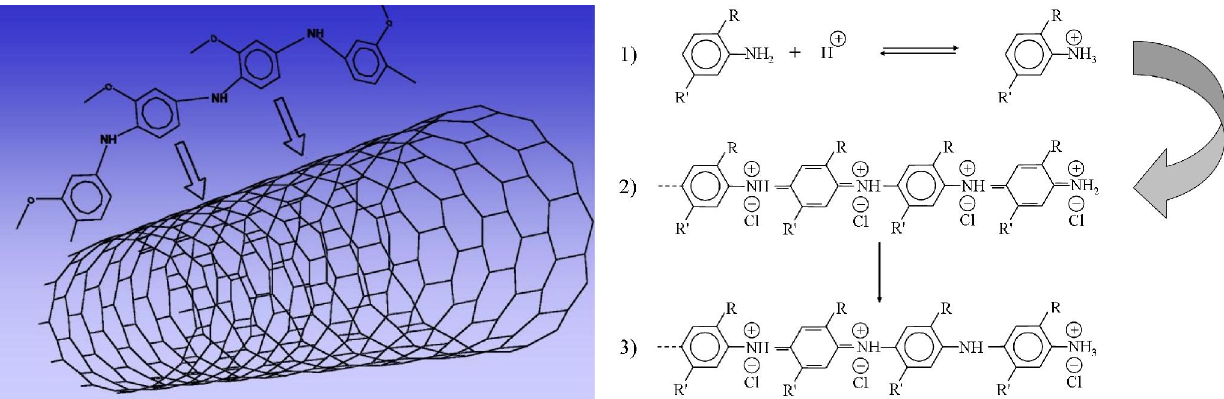
Figure 4. Left: Representation of nanocomposite materials based on wrapped up polymer chains around CNTs without the formation of strong interactions. Right: Scheme of the protonated pernigraniline chains growing process by addition of anilinium cations in para position. Their stability is strictly ruled by the possible delocalization of the positive charges along the polymer backbone, which is increased by the best reachable alignment (“in a plane” zigzag configuration) of the benzene/quinoid-like